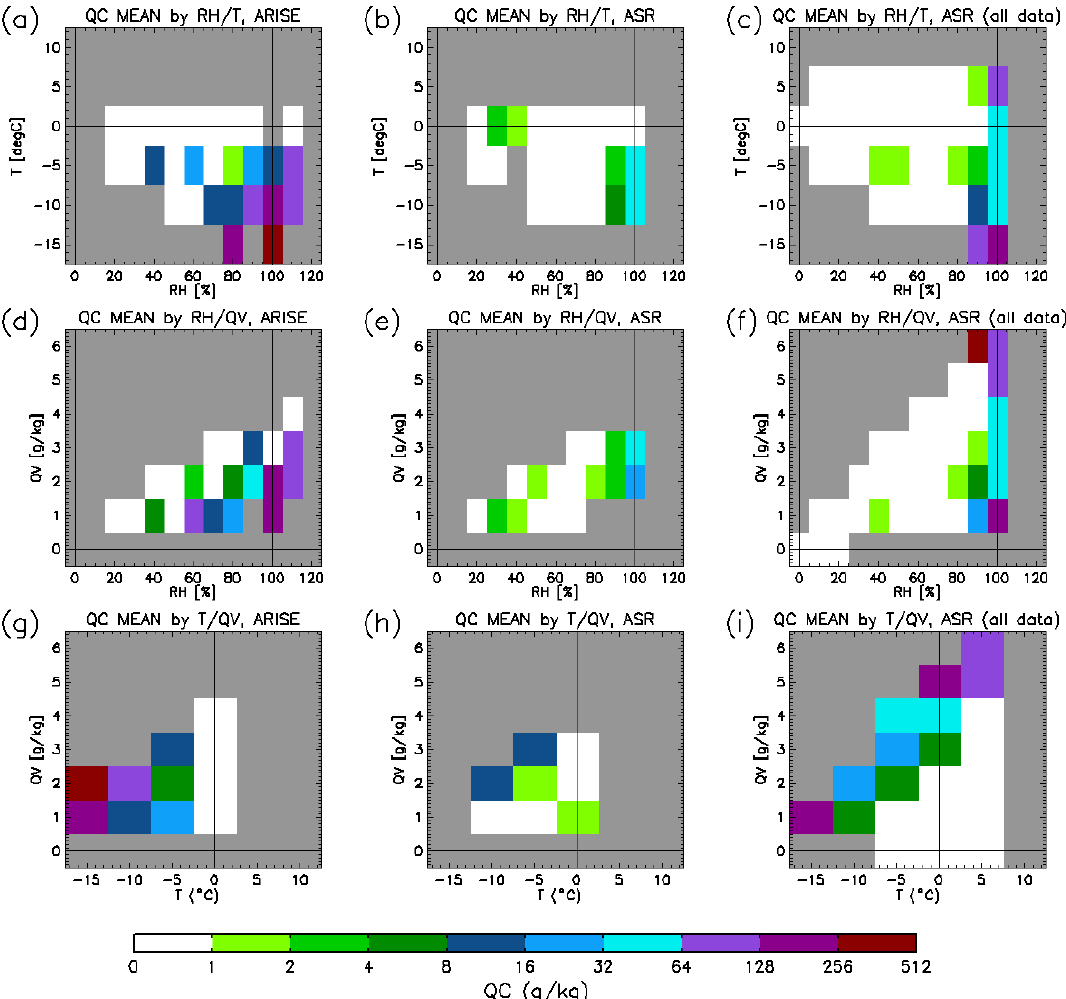
Figure 8. (a–c) Mean cloud water specific humidity (QC) for meteorological regimes characterized by temperature ( T ) and relative humidity (RH). Panel (a) shows ARISE-observed QC averaged by ARISE-observed RH and T ; (b) is collocated ASR QC averaged by collocated ASR RH and T , and (c) shows the ASR results for all pixels in the ARISE operational area at all times during the 8d of the ARISE flights (i.e., the population results). Note that gray boxes denote regimes which were not sampled by ARISE (a) or simulated by ASR (b, c) . (d–f) Same as (a–d) , but for regimes characterized by water vapor specific and relative humidities. (g–i) Same as (a–d) , but for regimes characterized by temperature and specific